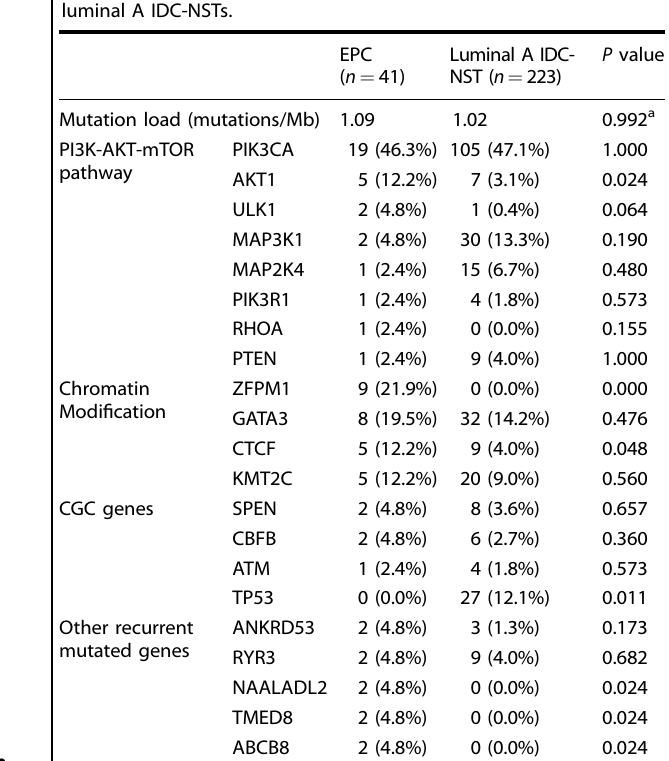
Fig. 7 DDR gene mutation in EPC and the TMB comparison between DDR mutated cases and wild type cases. a Each column denoted an individual tumor, and each row represented a gene. The different colors represented different mutation types. The TMB was shown at top. b The TMB comparison between DDR mutated cases and wild type cases, p = 0.007, Unpaired t test, Two-Tailed. DDR, DNA damage response and repair; MMR, mismatch repair.